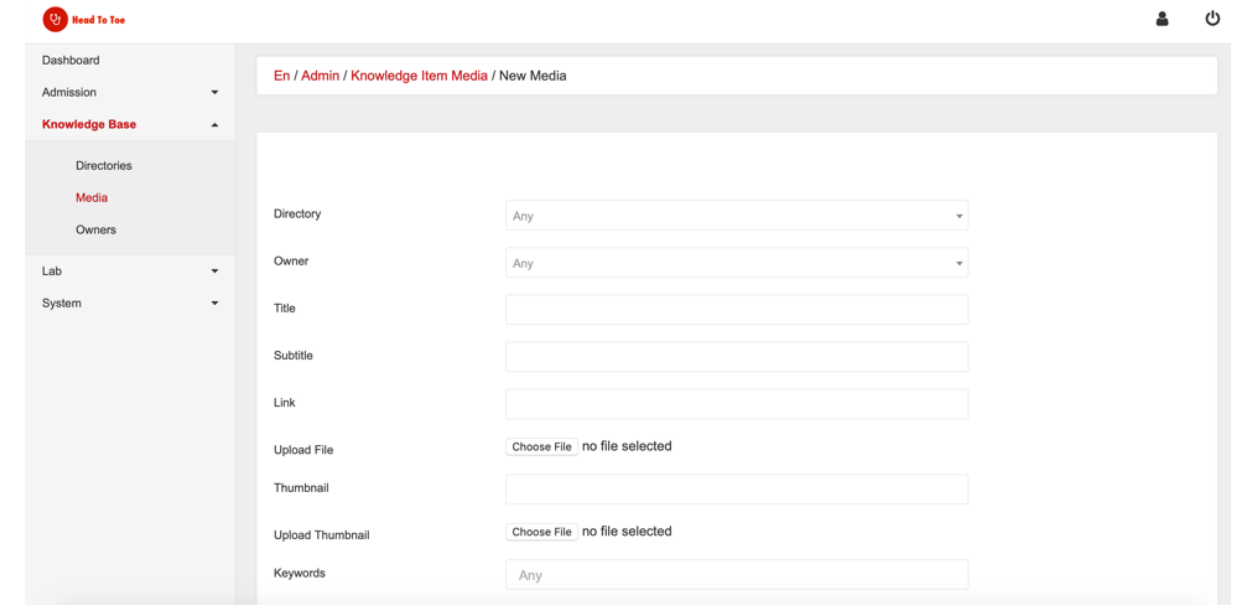
Figure 1. The administration interface of the HeadToToe platform. Educational content managers can use the interface to insert, update, and delete new content. Through the interface, administrators can also create the admission checklist for the admission checklist section as well as the laboratory values